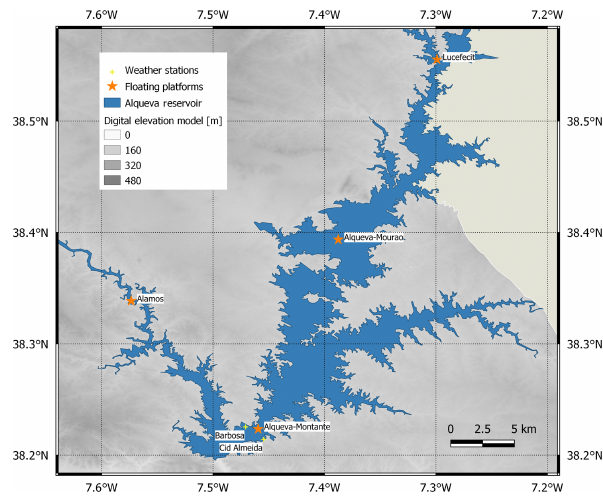
Figure 1. Location of the Alqueva reservoir and ALentejo Obser- vation and Prediction (ALOP) stations. The map was built using the digital elevation model of the ASTER Global Digital Elevation Model (GDEM) version 2 (https://asterweb.jpl.nasa.gov/gdem.asp, last access: 1 August